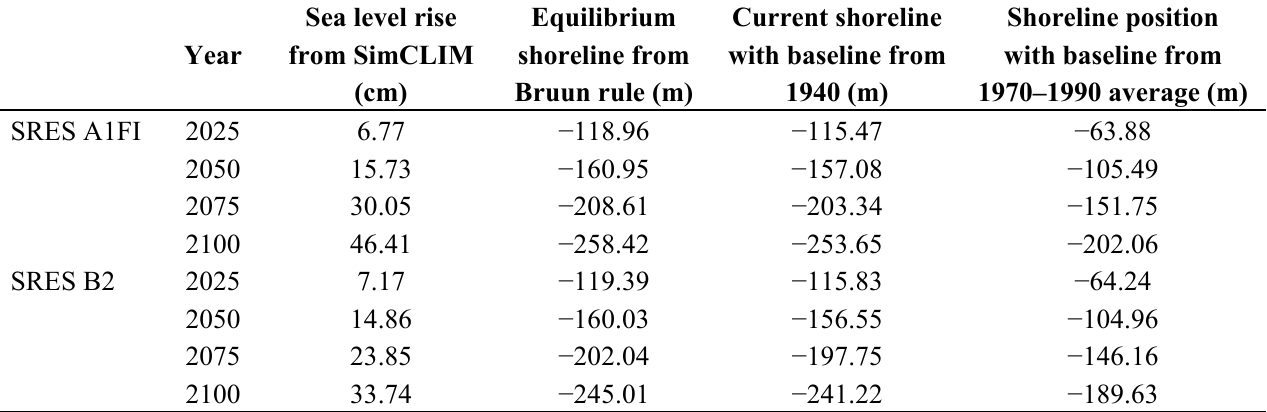
Table 2. Estimated long term sea level rise, equilibrium shoreline and the current shoreline position.